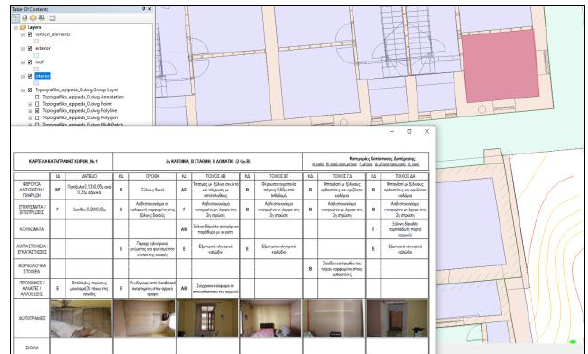
Figure 19 . The GIS application (linkage of features classes with registration bulletins).